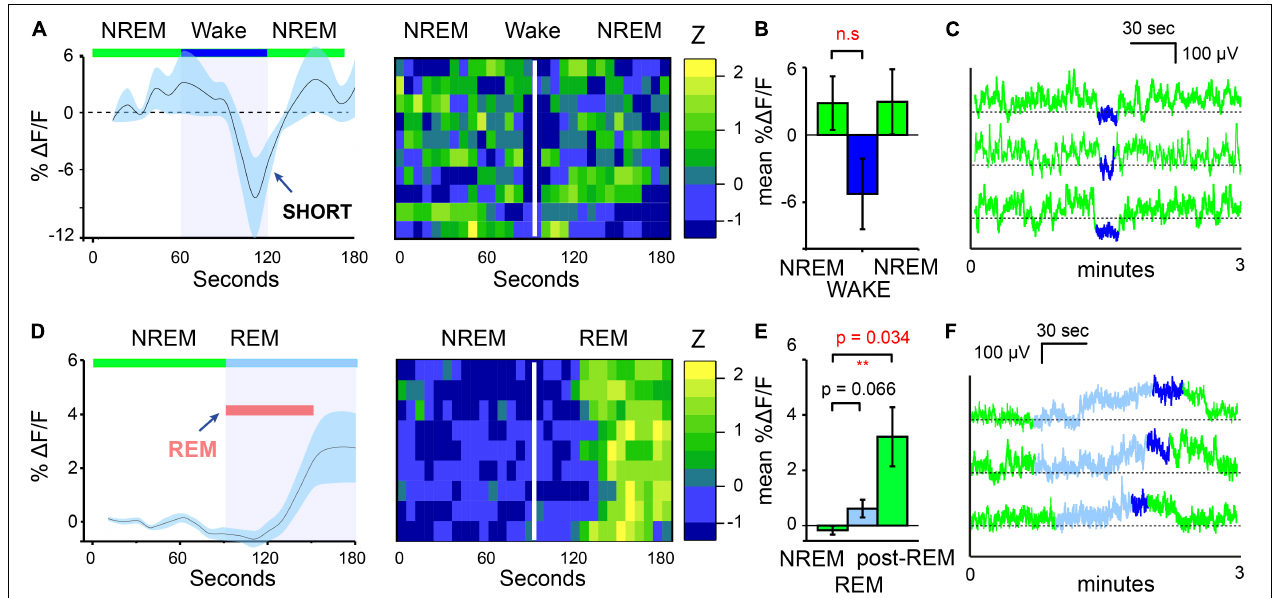
FIGURE 2 | MnPO/MPO hypothalamic NOS1 neurons are active during the later part of REM episodes. Animals were recorded for 6 h across the light cycle from lights-off to lights-on to facilitate obtaining a distribution of sleep states. Transitions are shown over 180 s. (A) The average (cid:49) F/F in calcium signal when NREM is interrupted by short bouts of wake. Wake length here is approximated and followed by ten example transitions, represented as a heatmap. (B) Mean change in (cid:49) F/F calcium signal between brief wakefulness, prior-NREM and post-NREM for short transitions (Paired t -test, n = 4, prior-NREM vs. brief wakefulness, p = 0.063, post-NREM vs. brief wakefulness p = 0.076). (C) Examples of NREM to wake transitions from raw photometry data colored by sleep-state (NREM, green; REM, cyan and wake, blue). (D) The average (cid:49) F/F for NREM to REM transitions showing no clear changes in signal with a slower increase after approximately 30 s alongside a heat map of nine transitions from NREM to REM sleep. (E) Mean change in (cid:49) F/F calcium signal between the end of a NREM period and the later part of a REM episode (Paired t -test, n = 5, p = 0.066) and NREM and post-REM (Paired t -test, n = 5, p = 0.034). (F) Examples of calcium signals during NREM to REM to microwake to NREM transitions, colored by sleep-state (NREM, green; REM, cyan; wake, blue). ** P < 0.01, n.s, not